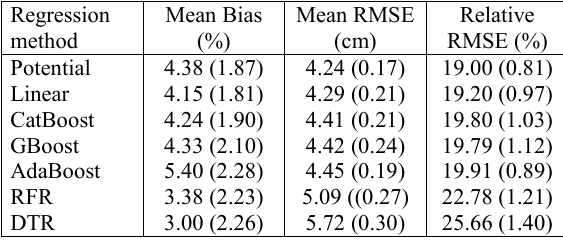
Table 2 . Statistics of systematic and random error for bivariate allometric models DBH = Φ(H). Figures in parentheses correspond to the standard